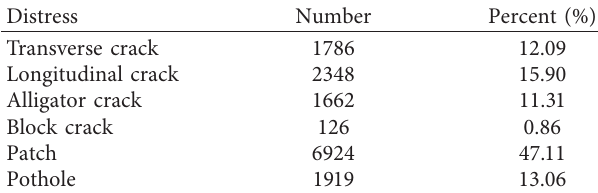
Table 1: The numbers of all distress types.